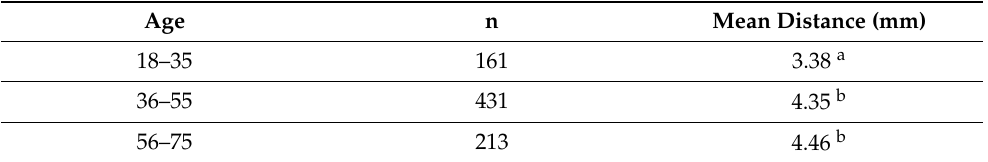
(n = number of teeth in each age